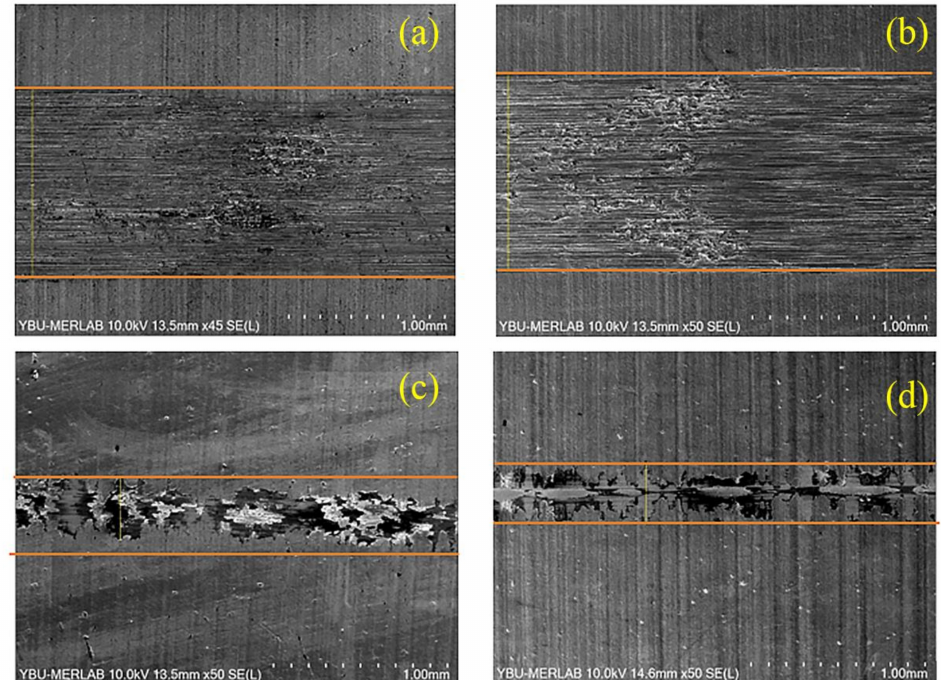
Figure 7. SEM morphologies of the wear tracks of substrates: ( a ) Ti-6Al-4V ( b ) Heat-treated Ti-6Al-4V ( c ) Composite coating ( d ) Heat-treated composite coating. The orange lines show the wear mark width and the yellow lines are the parallel lengths calculated by the ImageJ